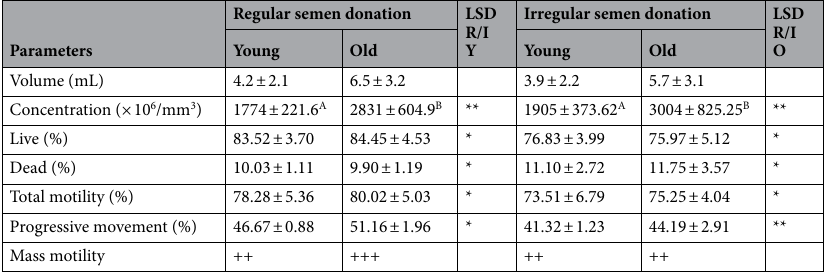
Table 8 shows the parameters of semen quality, taking into account age groups (Young–Old) and groups used on a regular and irregular basis. The volume of ejaculate was higher in the group of older (6.5 mL) and regular used bulls (old 6.5 mL; young 4.2 mL), but these differences were not statistically significant. Statistically, sperm concentration was highly significantly ( P < 0.01) highest in older bulls (2,831 × 106/mm3) and in bulls from both age groups, but used on a regular basis. The percentage of live sperm was higher in animals donating sperm regularly (in both age groups) by an average of 6.69% (young) and 8.54% (old). These differences were statistically, significantly ( P < 0.05) higher in the group of bulls giving sperm regularly, regardless of the age of the male. The opposite tendency was observed for the percentage of dead sperm—in the group of regularly used there were significantly less ( P < 0.05) dead sperm than in the group that donated irregularly. There was no significant difference between age groups in this parameter. Regularly used bulls, regardless of age, had better sperm motility results (total motility and progressive movement). Moreover, the semen of older bulls showed better total motility and progressive movement in comparison to younger bulls, regardless of the regularity of semen collection. The mobility of the sperm mass was higher (+++) in older bulls used regularly than in younger males (++). There were no differences in sperm mass motility in bulls used irregularly.